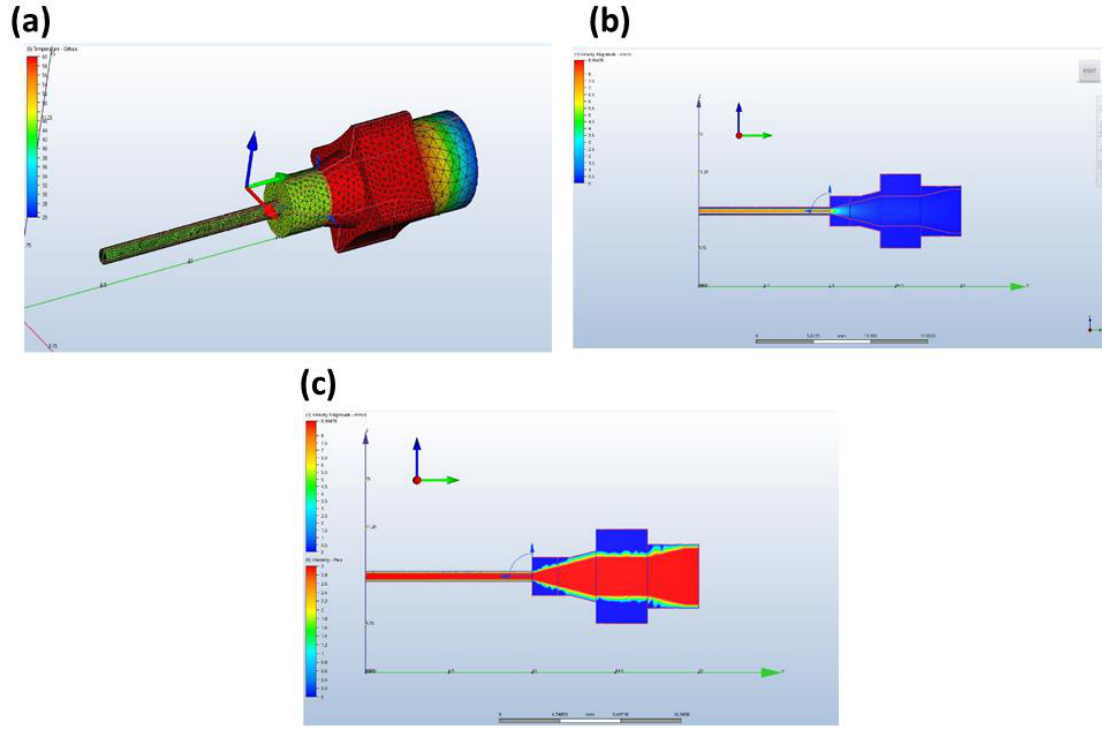
Figure 13. ( a ) Temperature distribution along nozzle, ( b ) velocity and ( c ) viscosity distribution of silicone resin along nozzle.